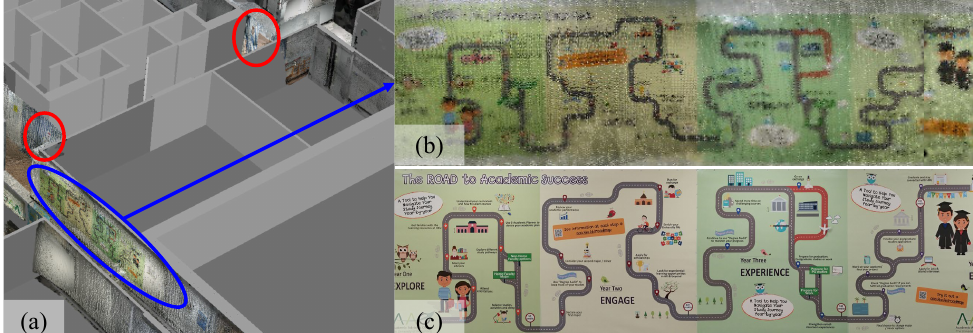
Figure 12. Temporary construction works and indoor textures in the DTB. ( a ) Temporary construction works circled in red; ( b ) textures in the DTB; ( c ) ground truth of the